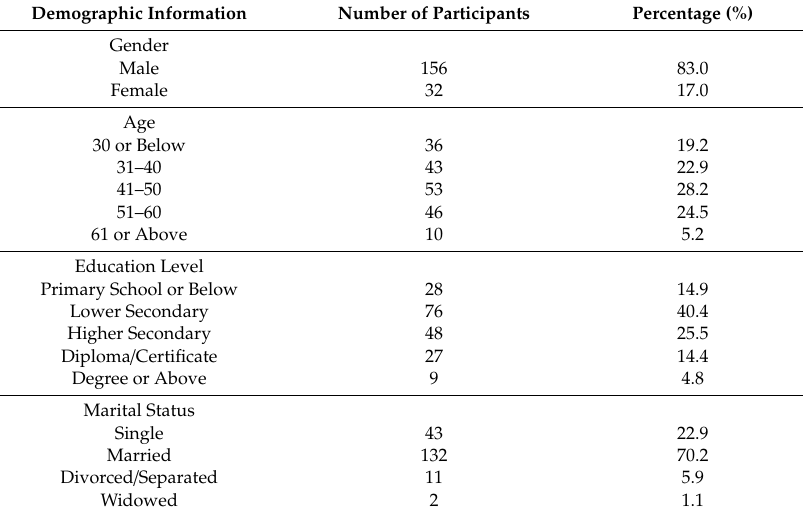
Table 2. Summary of participant characteristics ( N =